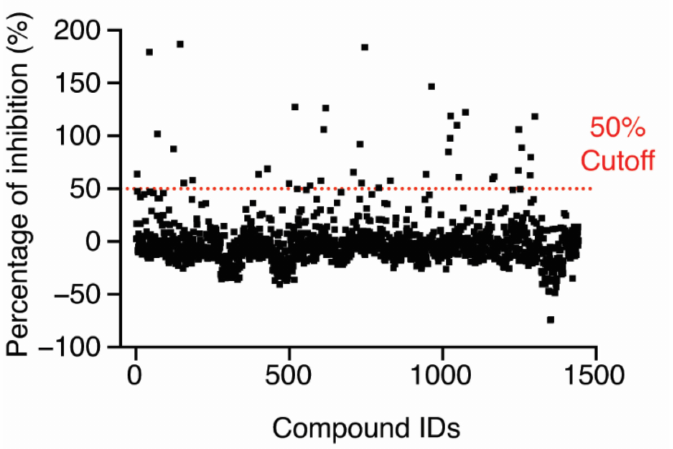
Figure 3. Screening of an FDA-approved drug library (1443 compounds) for inhibition of the LPS– CARD interaction. The dashed line indicates 50% inhibition in the presence of 10 µ M